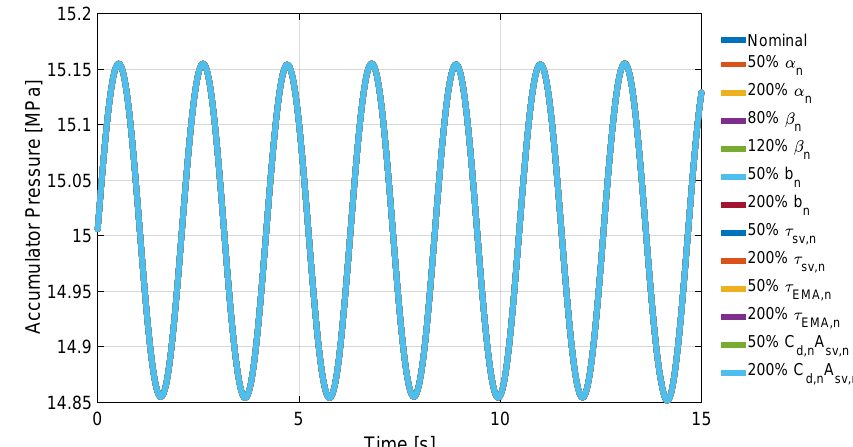
Figure 14. Simulation #2: Accumulator Pressure.